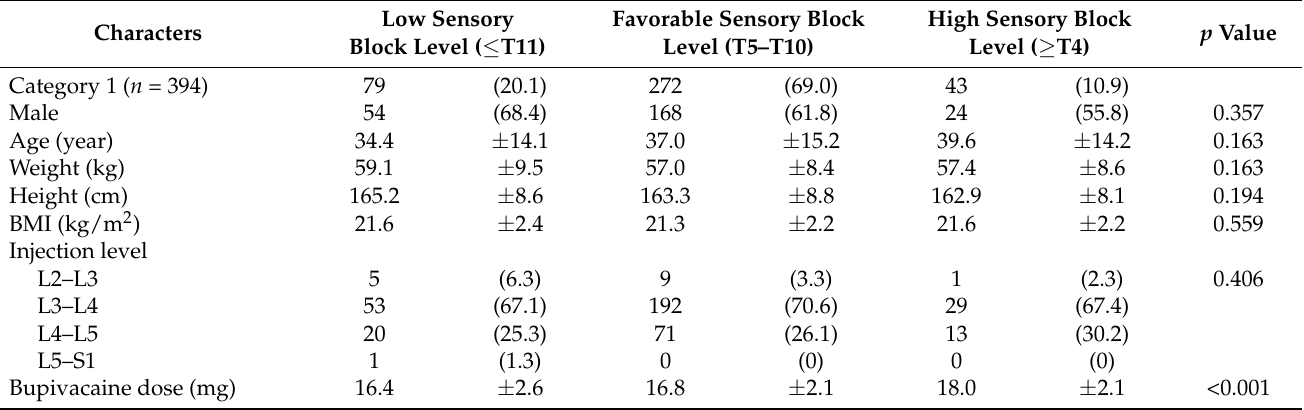
Table 2. Clinical characteristics of the study patients categorized according to age and body mass index compared across sensory block